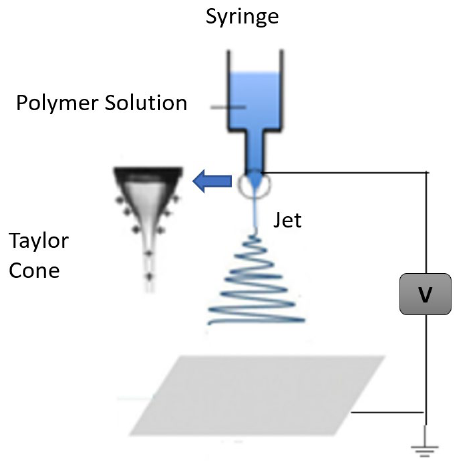
Figure 3. Diagrammatic illustration of electrospinning setup. The Taylor cone develops at the capillary tip when electrostatic forces are greater than the surface tension force, and the solution stream is ejected. The molecular weight of the polymer, chain entanglement, and solvent used during execution determines whether the jet will form a continuous fiber or scatter into droplets. Some studies have noted that smooth fibers are created when Berry’s number, B e = η c , which is a measure of polymer’s intrinsic viscosity ( η ) and polymer concentration ( c ), is higher than a certain critical value B e _ cr , which is characteristic of polymer [38]. A polymer solution’s specific viscosity is calculated using the ratio: